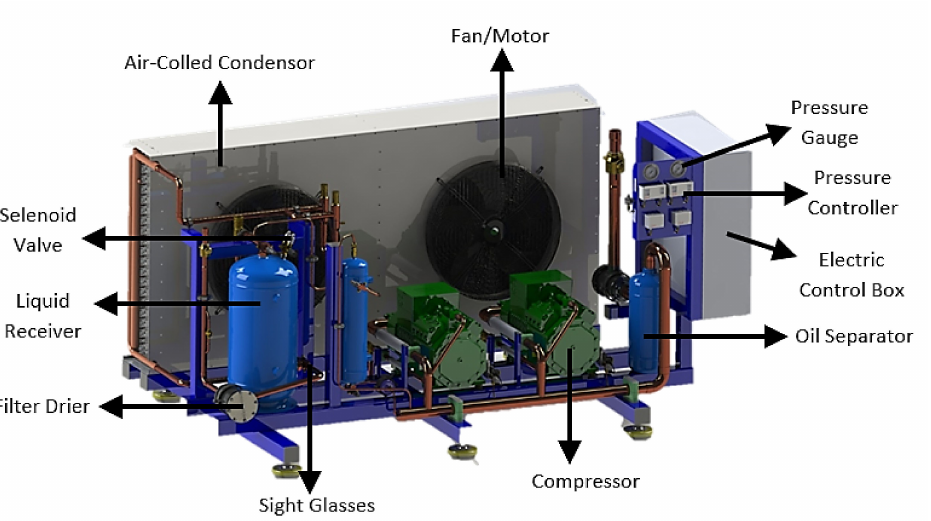
Figure 4. Condensing Unit